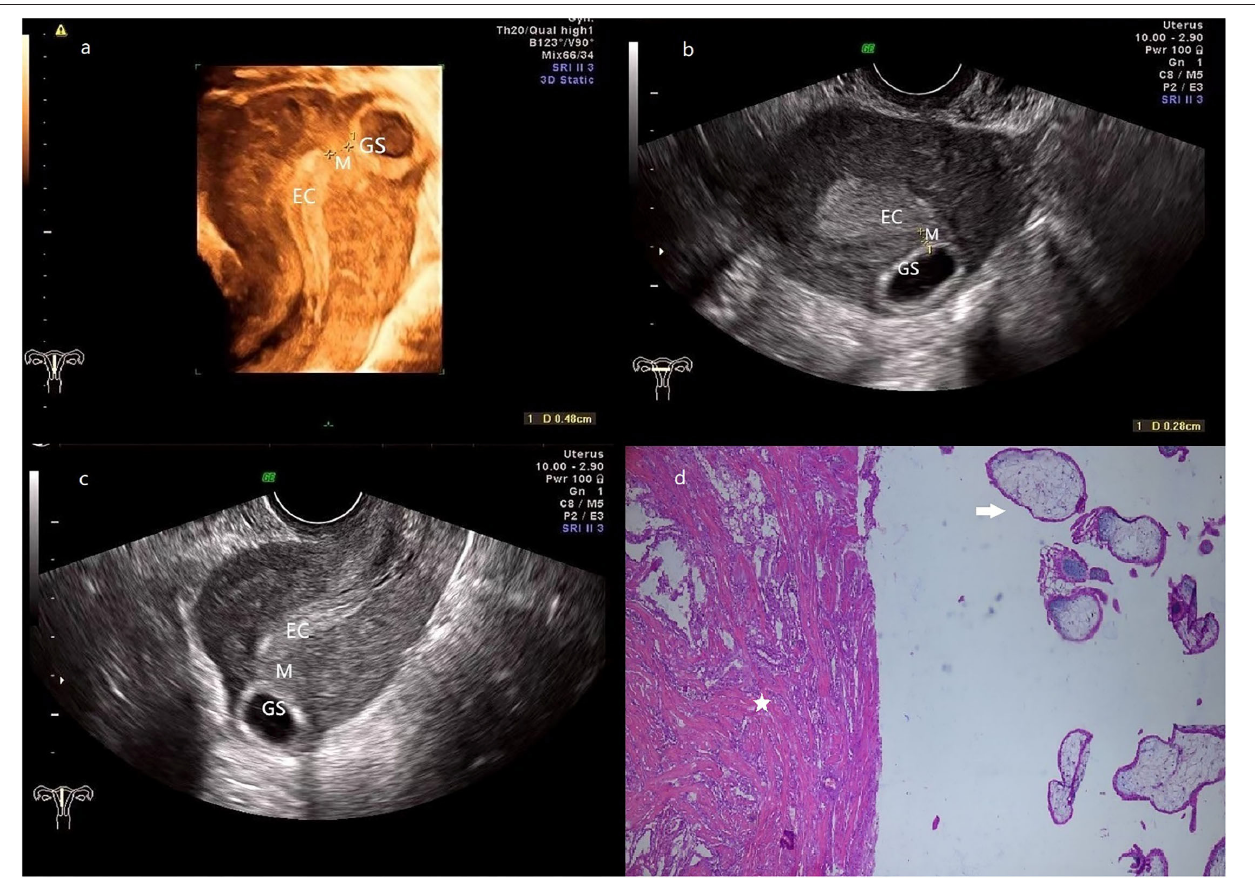
FIGURE 2 | (a) 3-D ultrasonography reveals the relative location of EC, GS (a size of 2.7*1.0cm), and the myometrium (0.5cm in thickness) is located between them. (b,c) transversal (b) and sagittal (c) section image showed that the GS is located at the left posterior wall of the fundus, and the connection with EC is disrupted by the myometrium. (d) The pathologic examination demonstrates that muscular tissue (star) coexists with the chorionic villus (arrow). (Patient 2, GS, gestational sac; M, myometrium; EC, endometrial